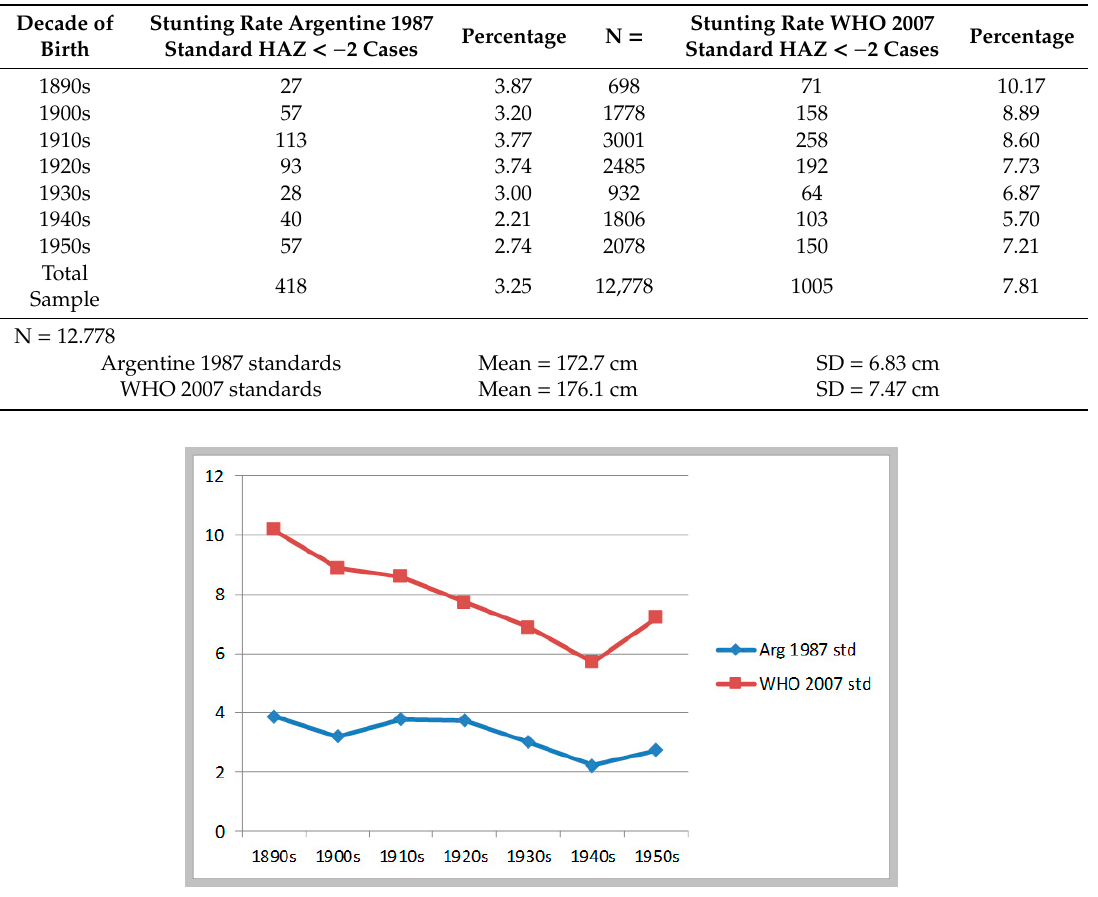
Table 6. Stunting rates by decade Recruits from Pampa Region b.1916–1951.